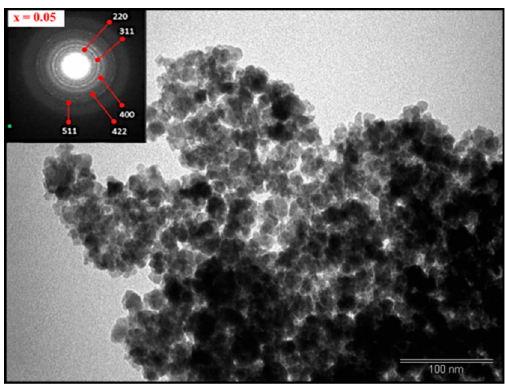
Figure 3. TEM image of selected x = 0.05 nanoferrite (Inset: corresponding selected angle electron diffraction (SAED) pattern).